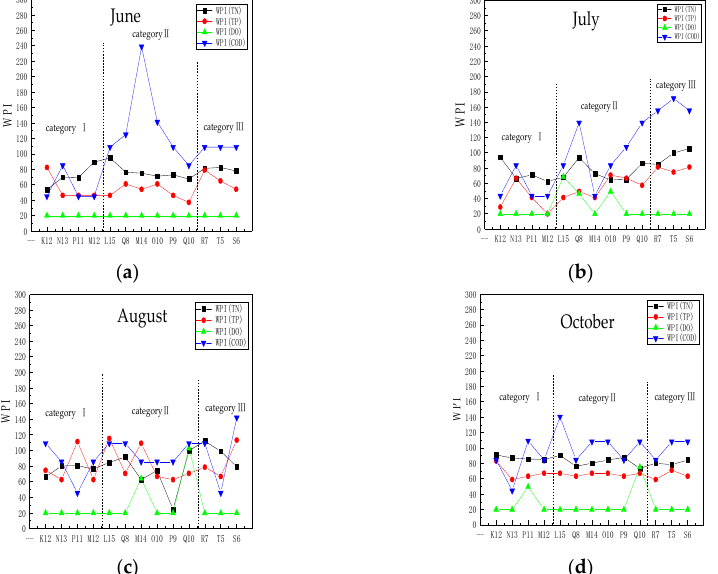
Figure 13. Spatial variation in the WPI in each sampling site in the wet season: ( a ) June; ( b ) July; ( c ) August; ( d ) October.